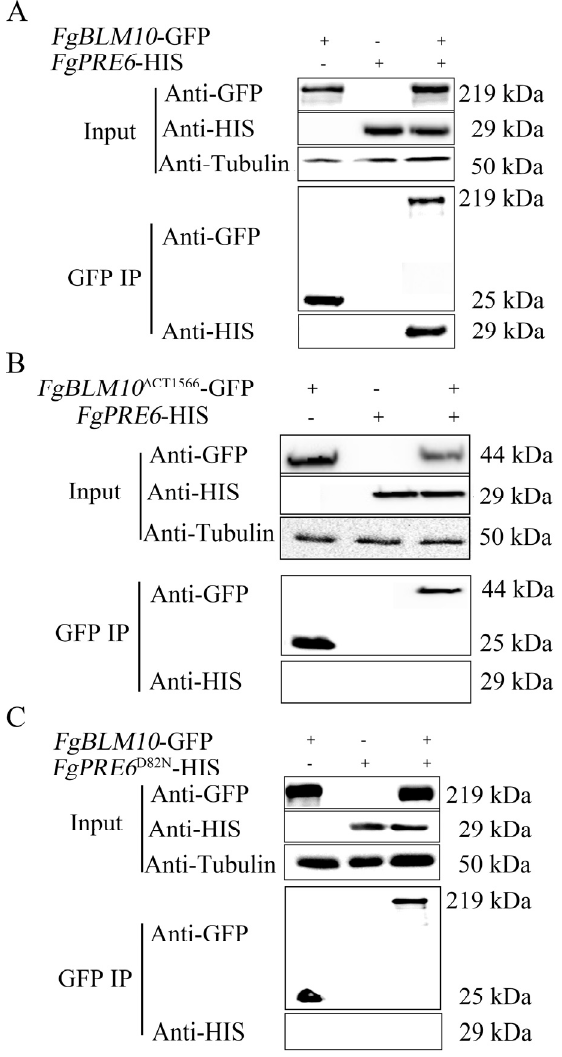
Figure 6. co-IP assays for the interaction of FgPre6 and FgPRE6 D82 with FgBlm10 and FgBlm10 ∆ CT1566 . ( A ) Western blots of total proteins (In for input) isolated from transformants expressing the FgPRE6 - His and FgBLM10 -GFP constructs and proteins immuno-precipitated (IP) with anti-GFP agarose beads were detected with the anti-GFP and anti-His antibodies. Detection with an anti- tubulin antibody was included as the negative co-IP control. ( B ) Western blots of total proteins and proteins immuno-precipitated with anti-GFP agarose beads of transformant expressing the FgPRE6 -His and FgBLM10 ∆ CT1566 -GFP constructs were detected with anti-GFP, anti-His antibodies, or anti- tubulin antibody. ( C ) Western blots of total proteins and proteins immuno-precipitated with anti-GFP agarose beads of transformant expressing the FgPRE6 D82N -His and FgBLM10 -GFP constructs were detected with anti-GFP, anti-His antibodies, or anti- tubulin